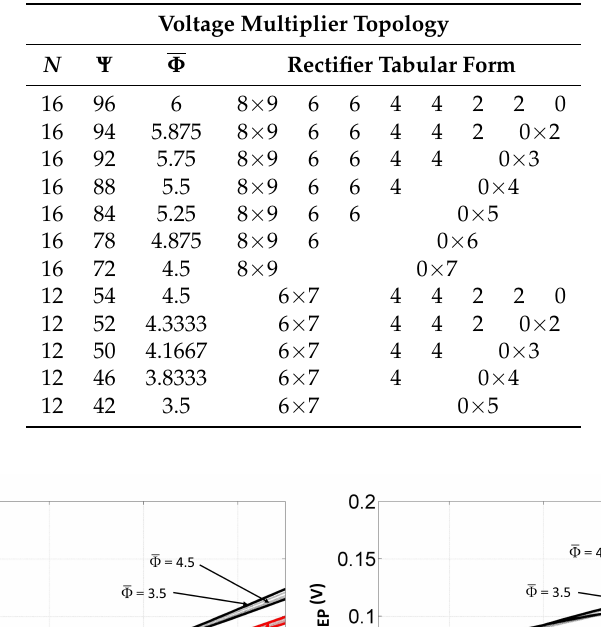
Table 2. Tabular form of the simulated voltage multipliers.